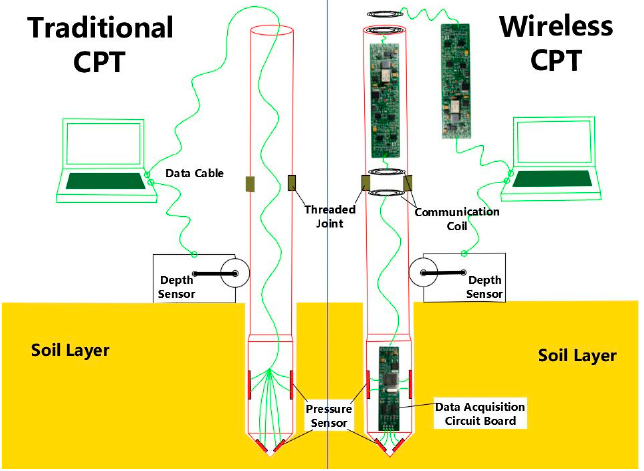
Figure 1. Schematic diagram of static cone penetration test.